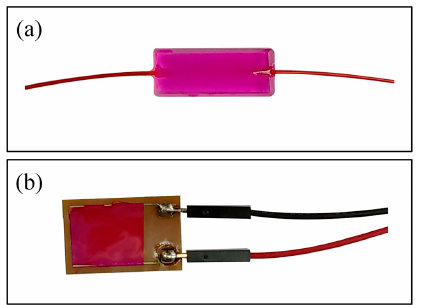
Figure 5. Fabricated temperature-sensing elements after deposition on the sensing membrane: ( a ) Fiber-optic and ( b ) IDE.